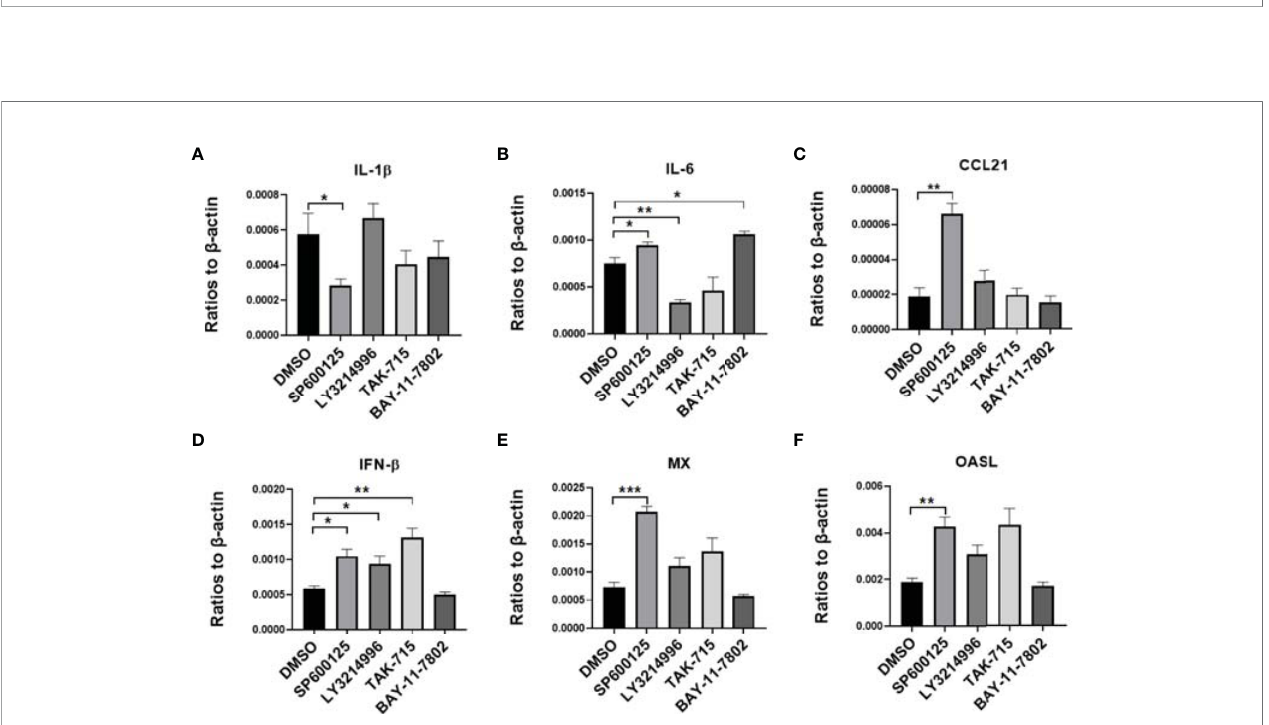
FIGURE 5 | IFN, ISGs, and cytokines were regulated by in fl ammatory signaling in duck DEF cells infected with the CHa strain. DEF cells were pretreated with SP600125 (JNK inhibitor), LY3214996 (ERK inhibitor), TAK-715 (p38 inhibitor) and BAY-117082 (NF-kB inhibitor) for 1 h at 10, 5, 5 and 5 M respectively, DMSO as control, then the cells were infected with CHa strain at 5 MOI for 1 h, then the same concentration of inhibitor was added. The expression level of IL-1 b (A) , IL-6 (B) , CCL21 (C) , IFN- b (D) , MX (E) , and OASL (F) were tested using RT-qPCR 24 h post-treatment. The relative expression was presented as ratios to b -actin compared to mock treatment. “ * ” was considered signi fi cant difference ( p < 0.05); “ ** ” was considered highly signi fi cant difference ( p < 0.01); “ *** ” was considered highly signi fi cant difference ( p < 0.001).